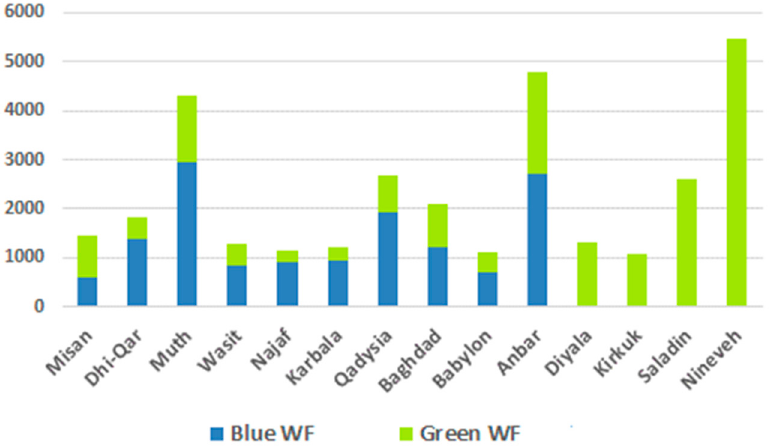
Figure 2. Components of wheat water footprint (WF) for the 15 Iraqi provinces (m 3 /ton).